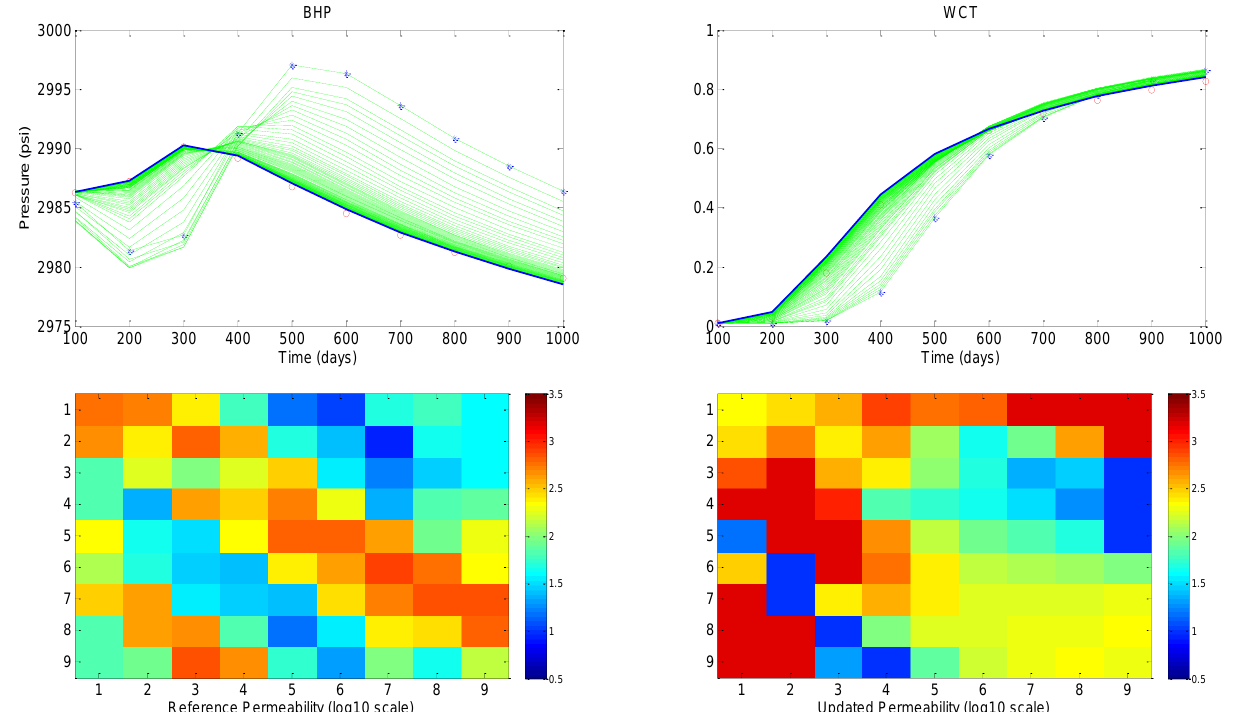
Figure 6—History of model calibration (BHP and